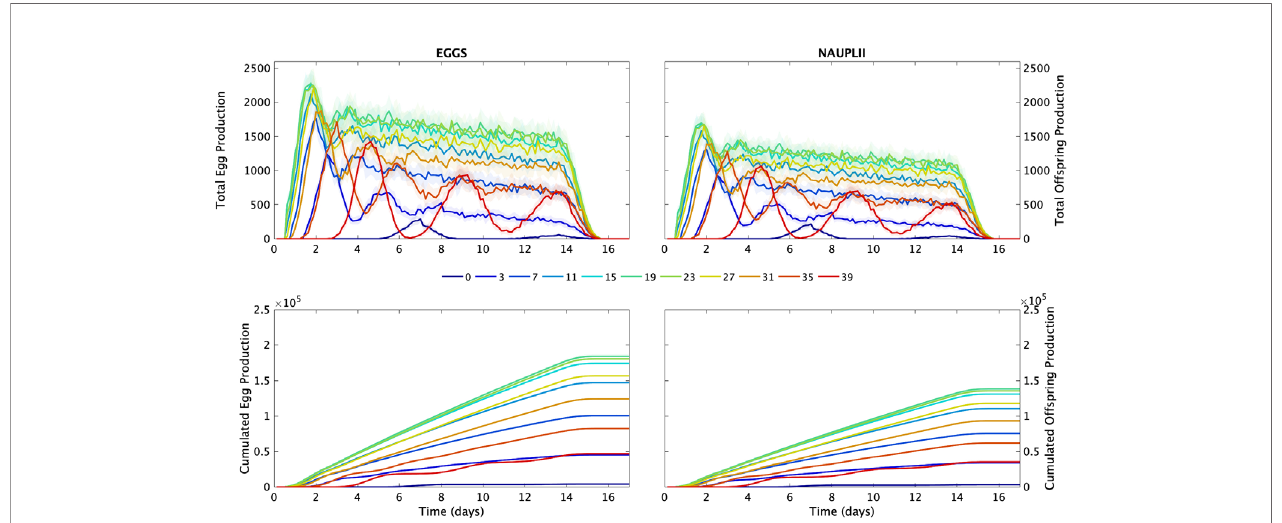
FIGURE 7 | Total production (Top) and cumulative production (bottom) of eggs (left) and offspring (right) by 1000 females over 20 days at different salinity conditions (PSU). All individuals died before the end of the simulation. The x-axis was therefore limited to 17 days. Lines represent the average over the 15 replicate simulations. The shaded area is the standard deviation.